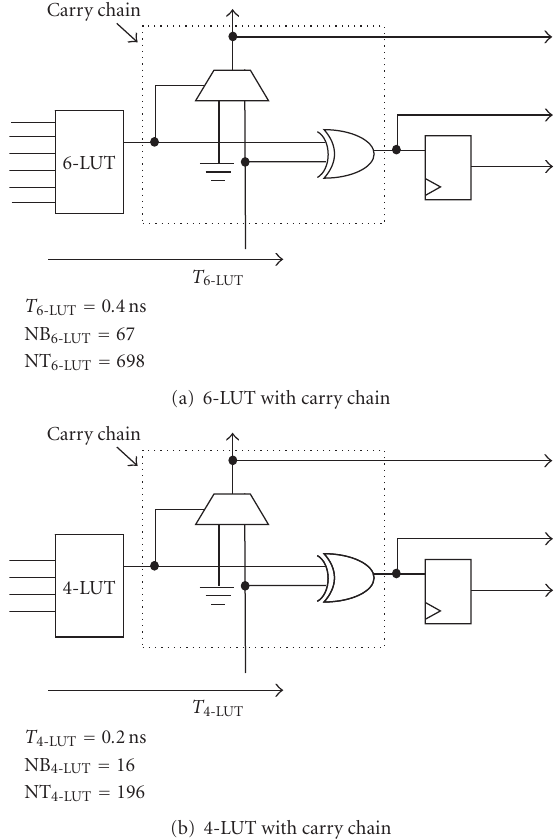
Figure 10: Homogeneous LUT structures with carry